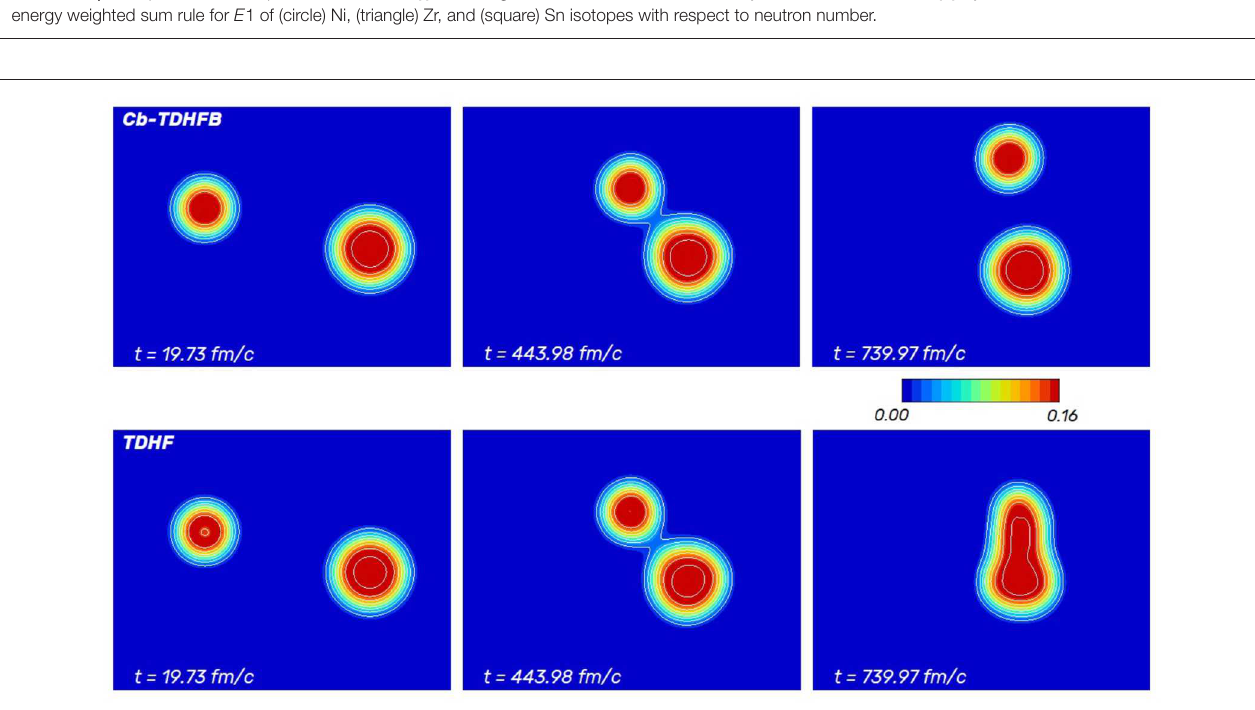
FIGURE 2 | Time-evolution of nucleon density for the 22 O+ 52 Ca collision reactions which are calculated by (Upper panels) Cb-TDHFB and (Lower panels) TDHF. The calculations are performed with the parameters b =4.1 fm and E in =35.6 MeV.